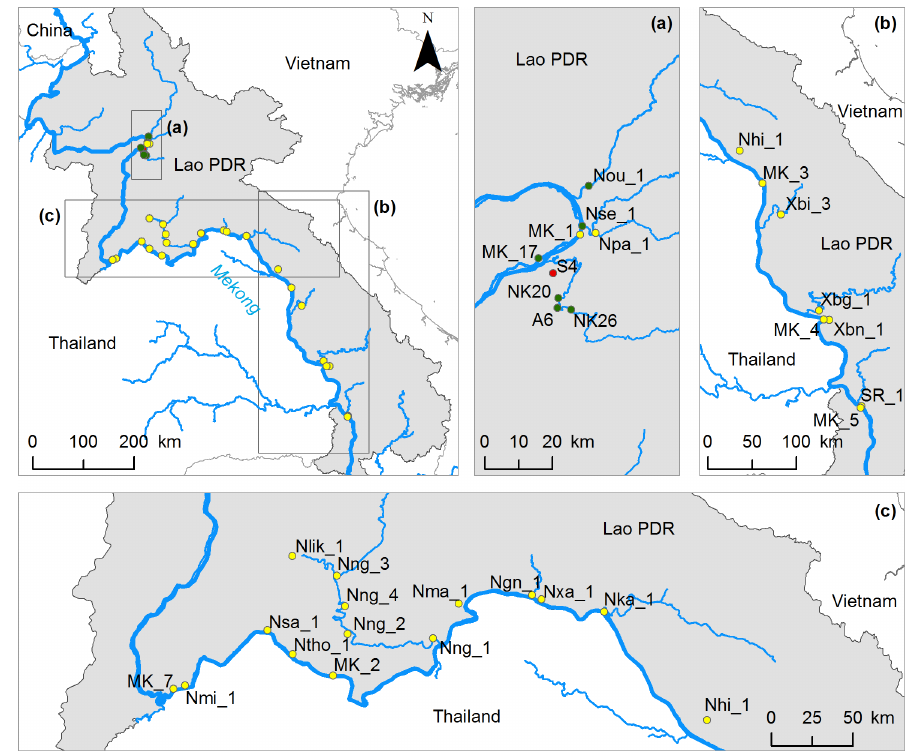
Figure 1. Location of the 31 sampling stations within the Mekong River basin in Lao PDR. Tributary names and catchment areas are given in Table 1. Red dot represents sampling station S4 and green dots represent sampling stations NK20, NK26, A6, Nou_1, Nse_1, and MK_17.